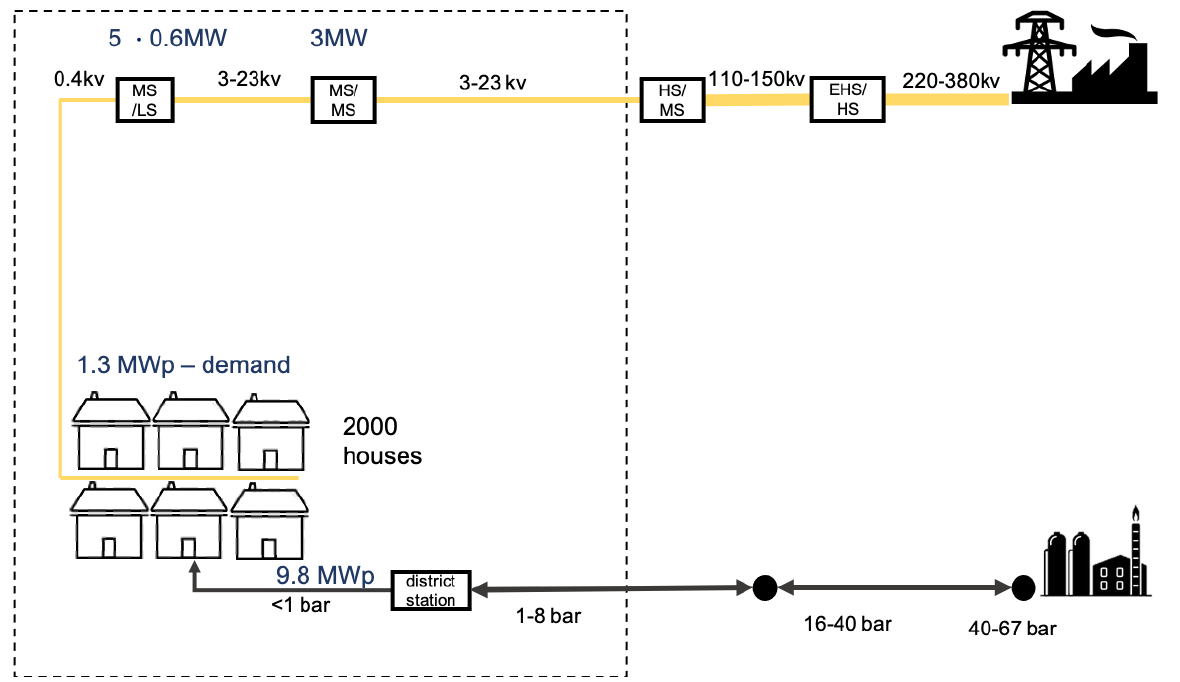
Figure 2. Schematic overview of the reference scenario without local renewable production, conversion and storage and with a gas grid for heating demand. This reference scenario has non-renewable electricity and natural gas as their energy sources. The energy demands are based on an existing neighborhood with 50% terraced houses and 50% apartments without solar PV. The houses have not yet been retrofitted and/or insulated.